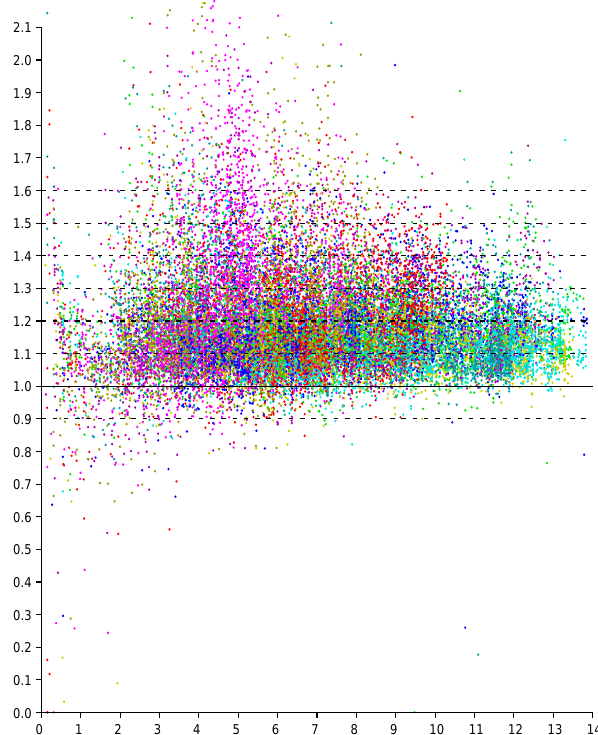
Figure 13. Scattergram of ratio of reported to actual distance (vertical axis) versus actual distance (horizontal axis—meters). Results from nine responders color coded. (Dashed lines are shown for ratios of 0.9, 1.0 1.1, 1.2 . . .